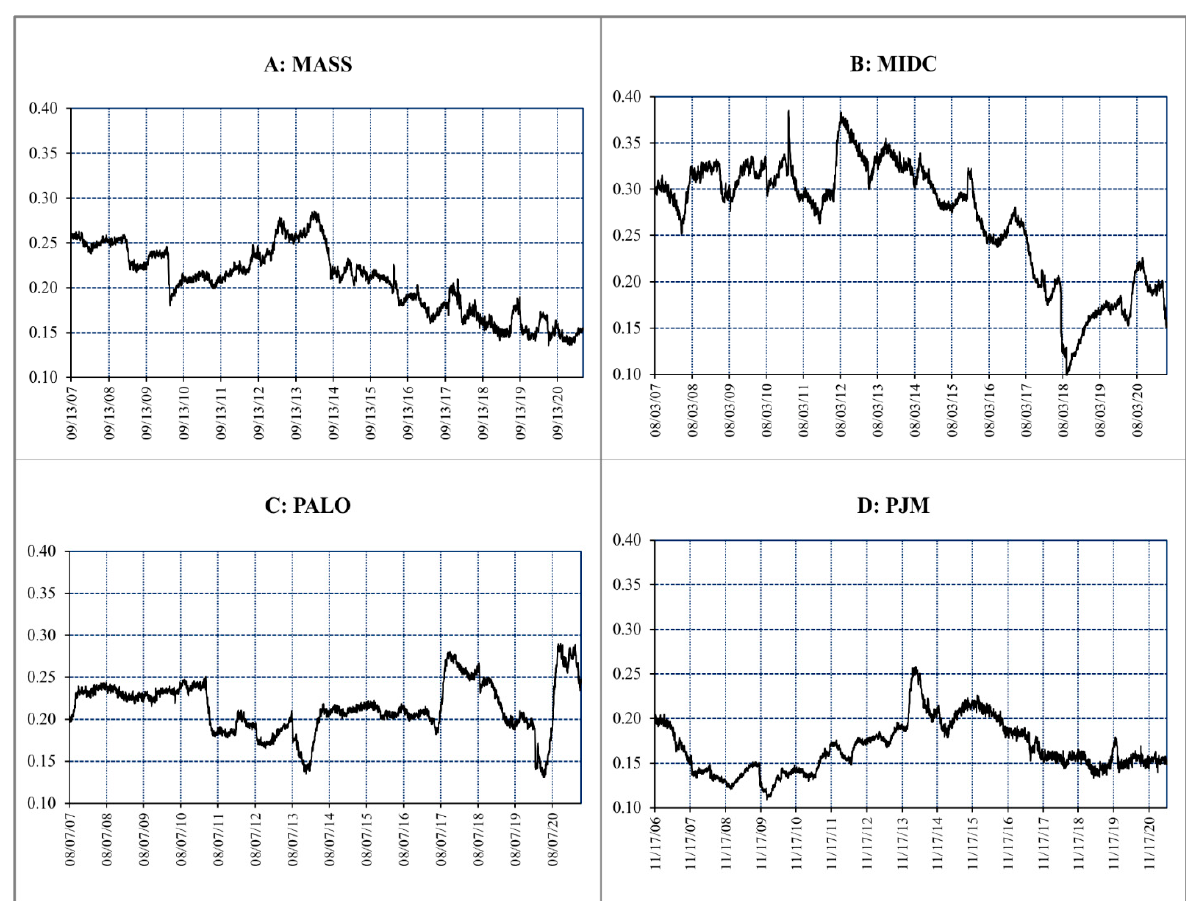
Figure 4. Dynamic evolution of multifractality degree for electricity indices ( MLM , and 𝑤𝑖𝑛𝑑𝑜𝑤 = 1500 ).